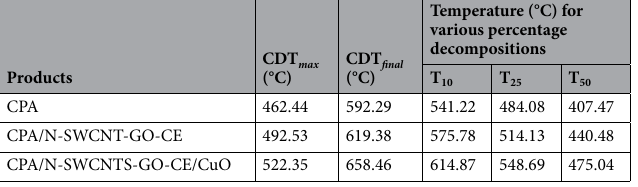
Table 1. Thermal behavior of CPA, CPA/N-SWCNT-GO-CE, and CPA/N-SWCNTS-GO-CE/CuO nanocomposites.